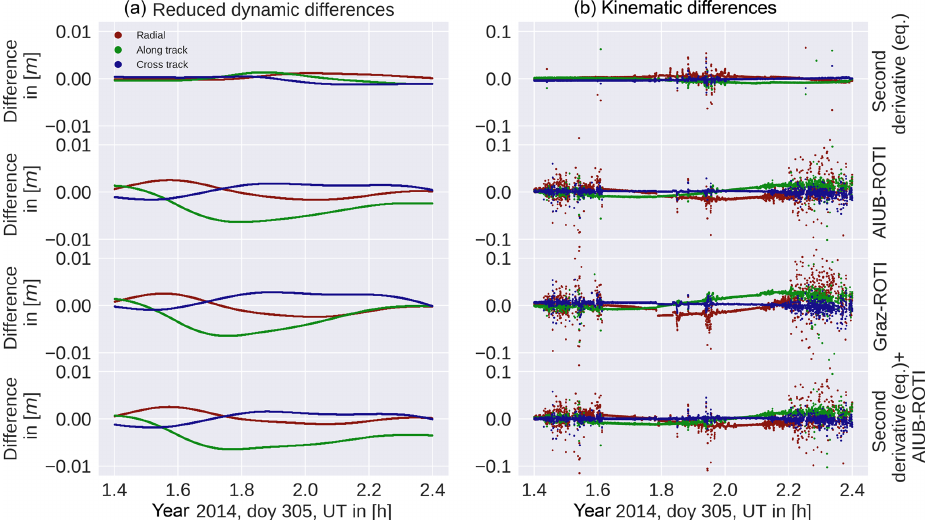
Figure 12. Differences between the unweighted positions of reduced-dynamic (a) and kinematic (b) orbits. All orbits were compared to the unweighted case. The second derivative-based weighting was limited to the equatorial region (eq.).